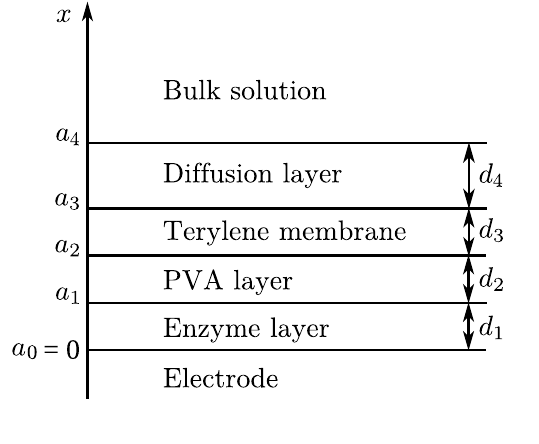
Figure 1. The principal structure of a biosensor. PVA, polyvinyl alcohol.